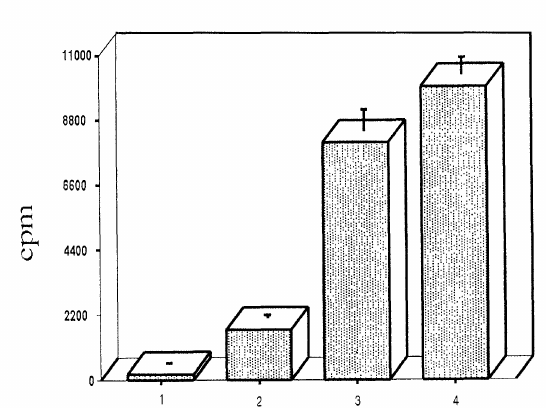
FIGURE 1. Proliferation of B cells in presence of CD57 or CD57- cells. B cells (105 cells per well) were incubated with the CD57 or CD57- cells (3 x 105 cells/well) and examined for proliferation after 48 hours of culture. The CD57 and CD57- cells were pretreated with mitomycin C (50 Iag/ml for 45 min) and activated with PHA (2 tg/ml). Levels of tritiated thymidine up- take are indicated in CPM. The results are expressed as the mean of quadriplicate cultures and are representative of 4 experiments performed. In 1: B cells alone; 2: B cells and CD57 cells; 3: B cells and CD57- cells; 4: B cells and unsorted CD4